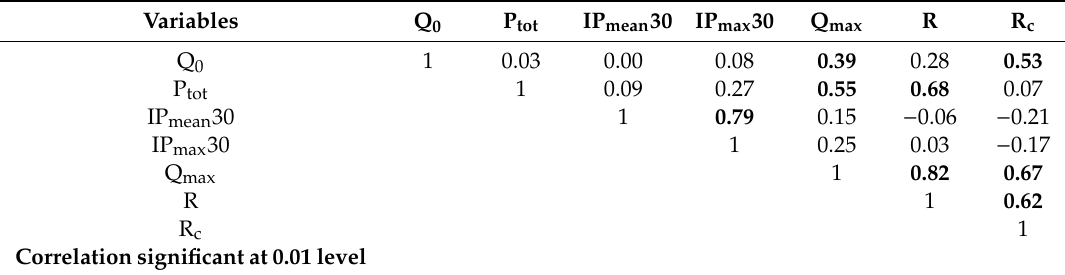
Table 2. Pearson correlation matrix between selected